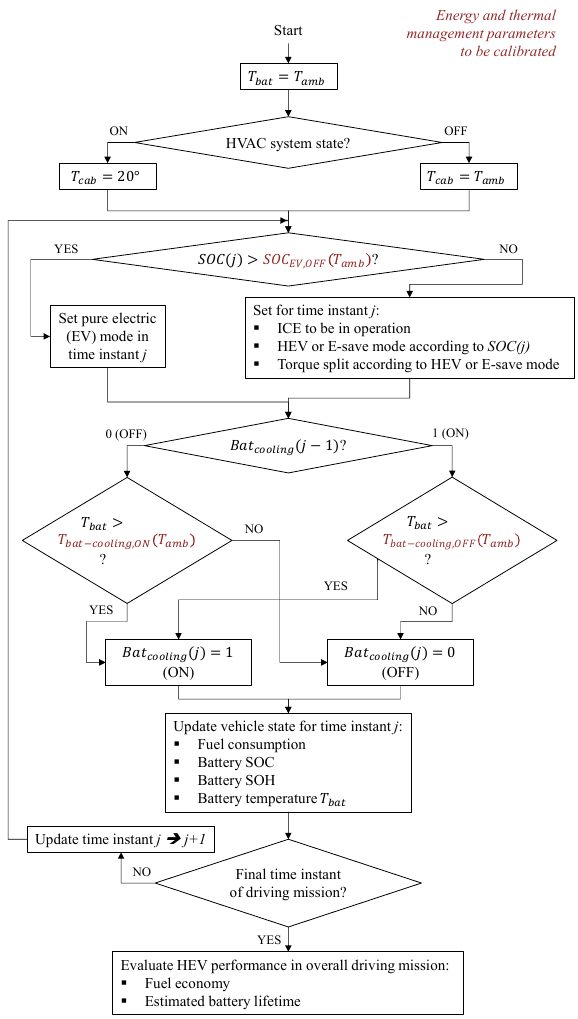
Figure 6. Flowchart for simulating the HEV in a driving mission according to the implemented energy and thermal management approaches.